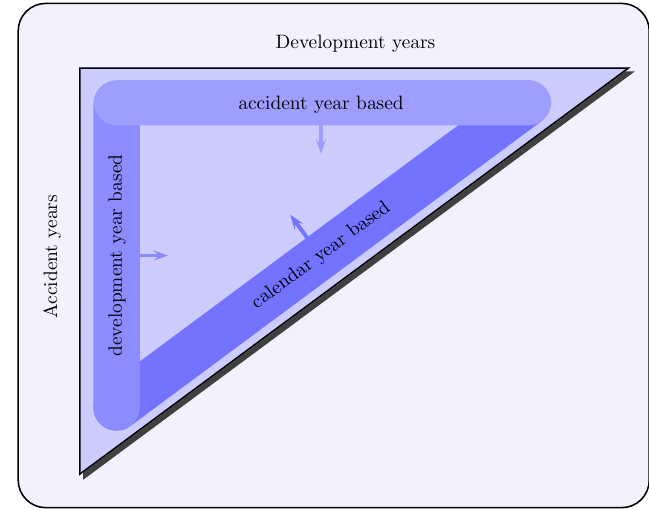
Figure 2. Modeling approaches of claims development